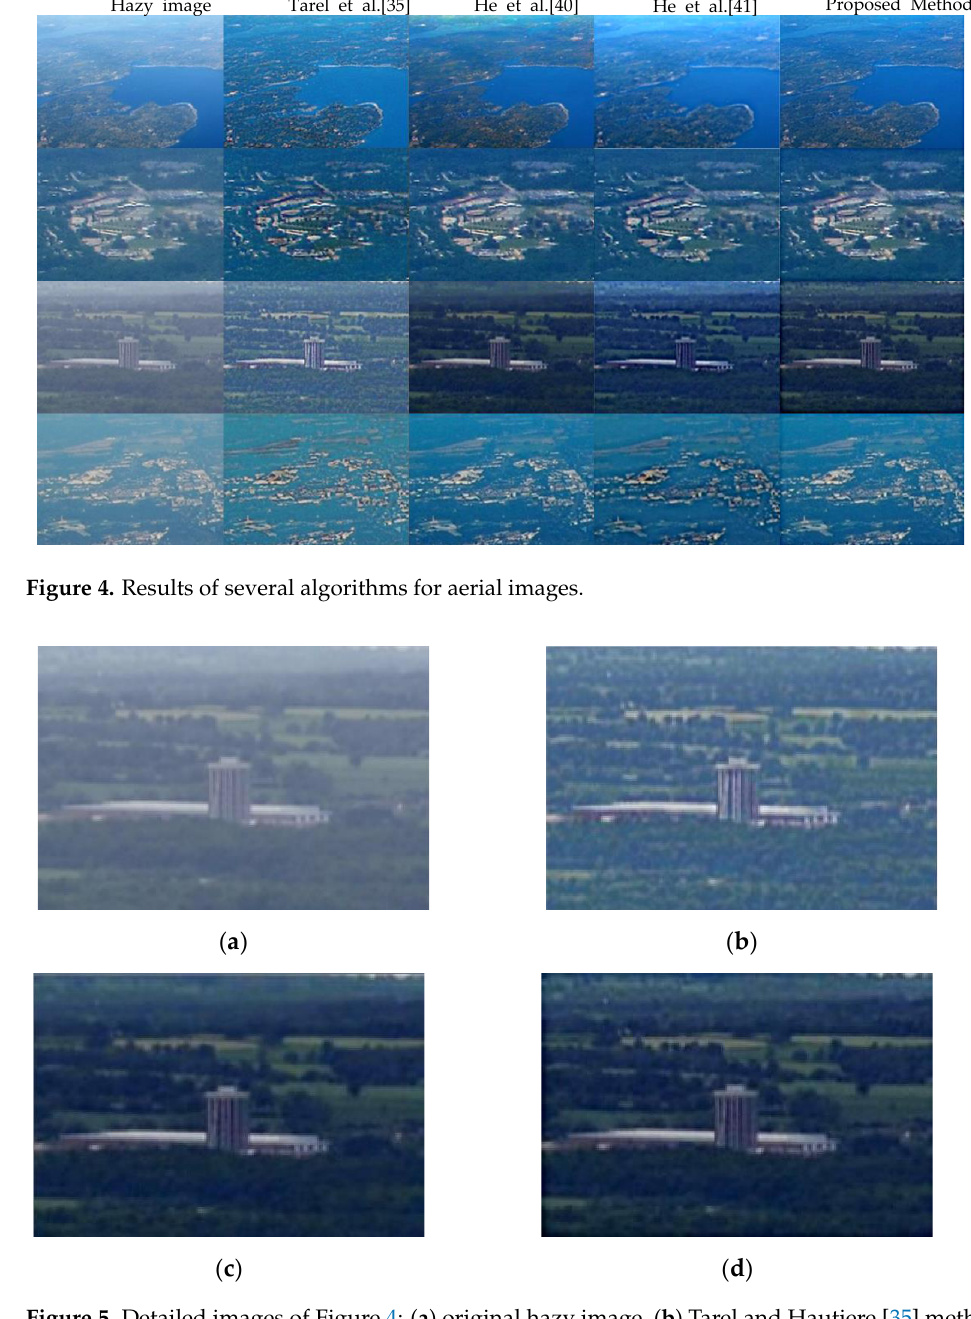
Figure 3. Test aerial images and dehazing result with large sizes: ( a ) original hazy images and ( b ) proposed method.